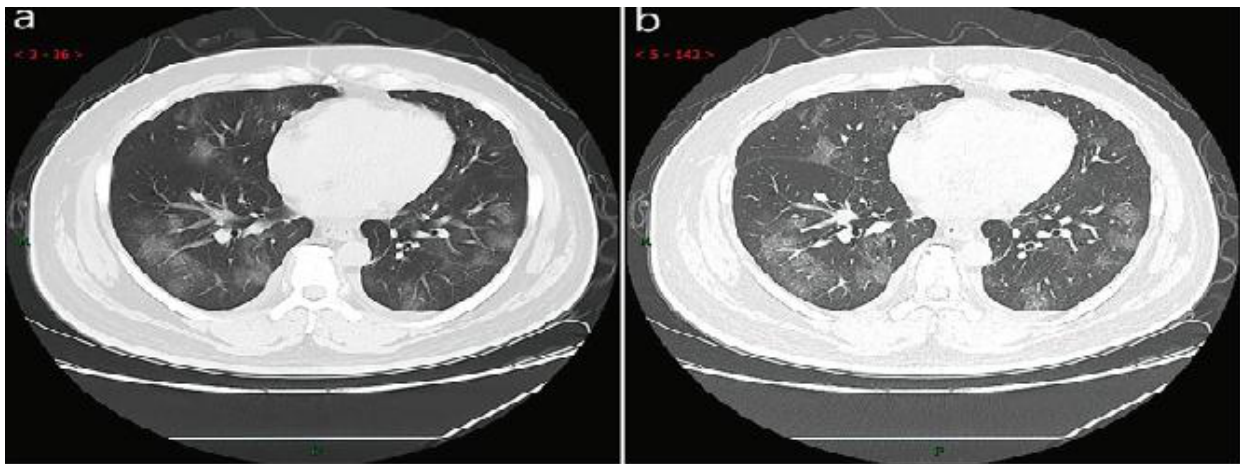
Figure 7: CT imaging of early stage. Male, 38 years old, fever without obvious inducement (39.3 ℃), dry cough and shortness of breath for 3 days. Laboratory test: decreased white blood cells (3.01 × 10 9 /L), decreased lymphocytes (0.81 × 10 9 / L), increased C- reaction protein (60.8 mg/L), increased procalcitonin (0.16 ng/ml). Imaging examination: a (thin layer CT) and b (high-resolution CT) showed multiple patchy and light consolidation in both lungs and grid-like thickness of interlobular septa.